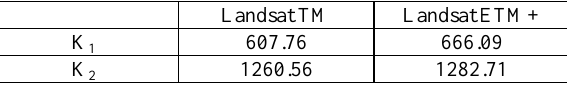
Table 1. coefficients of inverse of Plank’s equation for Landsat